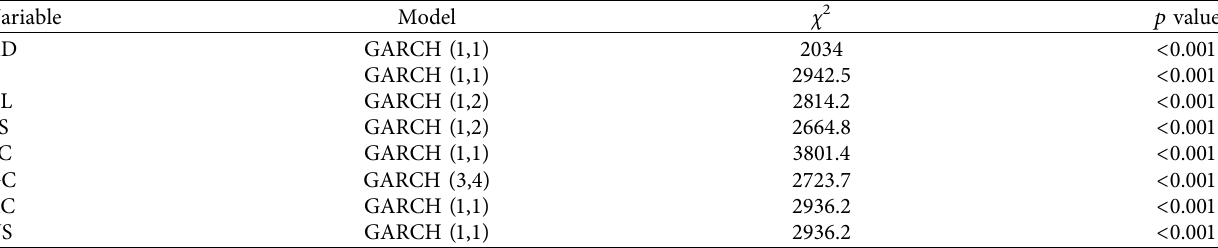
Table 8: Box-Ljung test for GARCH models.